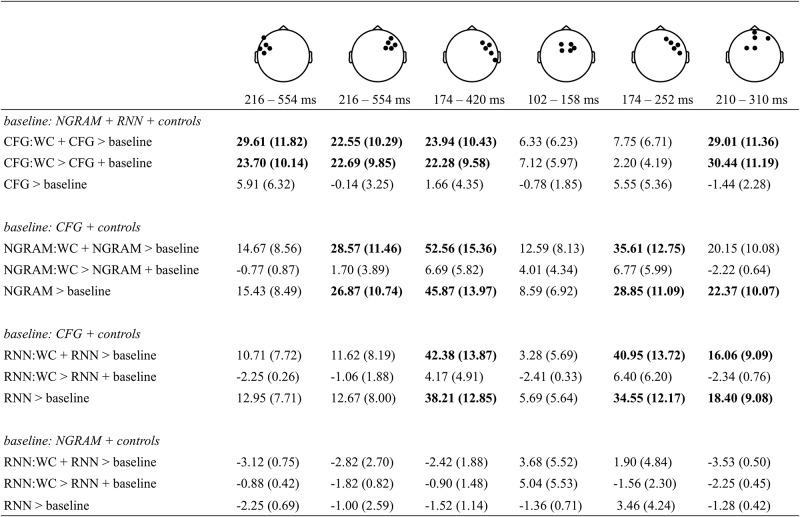
Model comparison results.WAIC difference scores (± standard error) indicate changes in model fit across six ROIs (columns). Each set of rows tests a different statistical question using step-wise model comparison. Terms that are being evaluated are indicated to the left of “>”; interactions with word-class are indicated with “:WC”. For each row-set, the baseline model includes all control covariates along with the indicated surprisal term(s) and interactions between word-class and those surprisal terms. The WAIC values are scaled so that positive numbers represent improvements for the larger model, while negative numbers indicate that the added complexity of the larger model is not matched by a better fit. Bold-face indicates WAIC improvements that are more than two standard errors from zero.